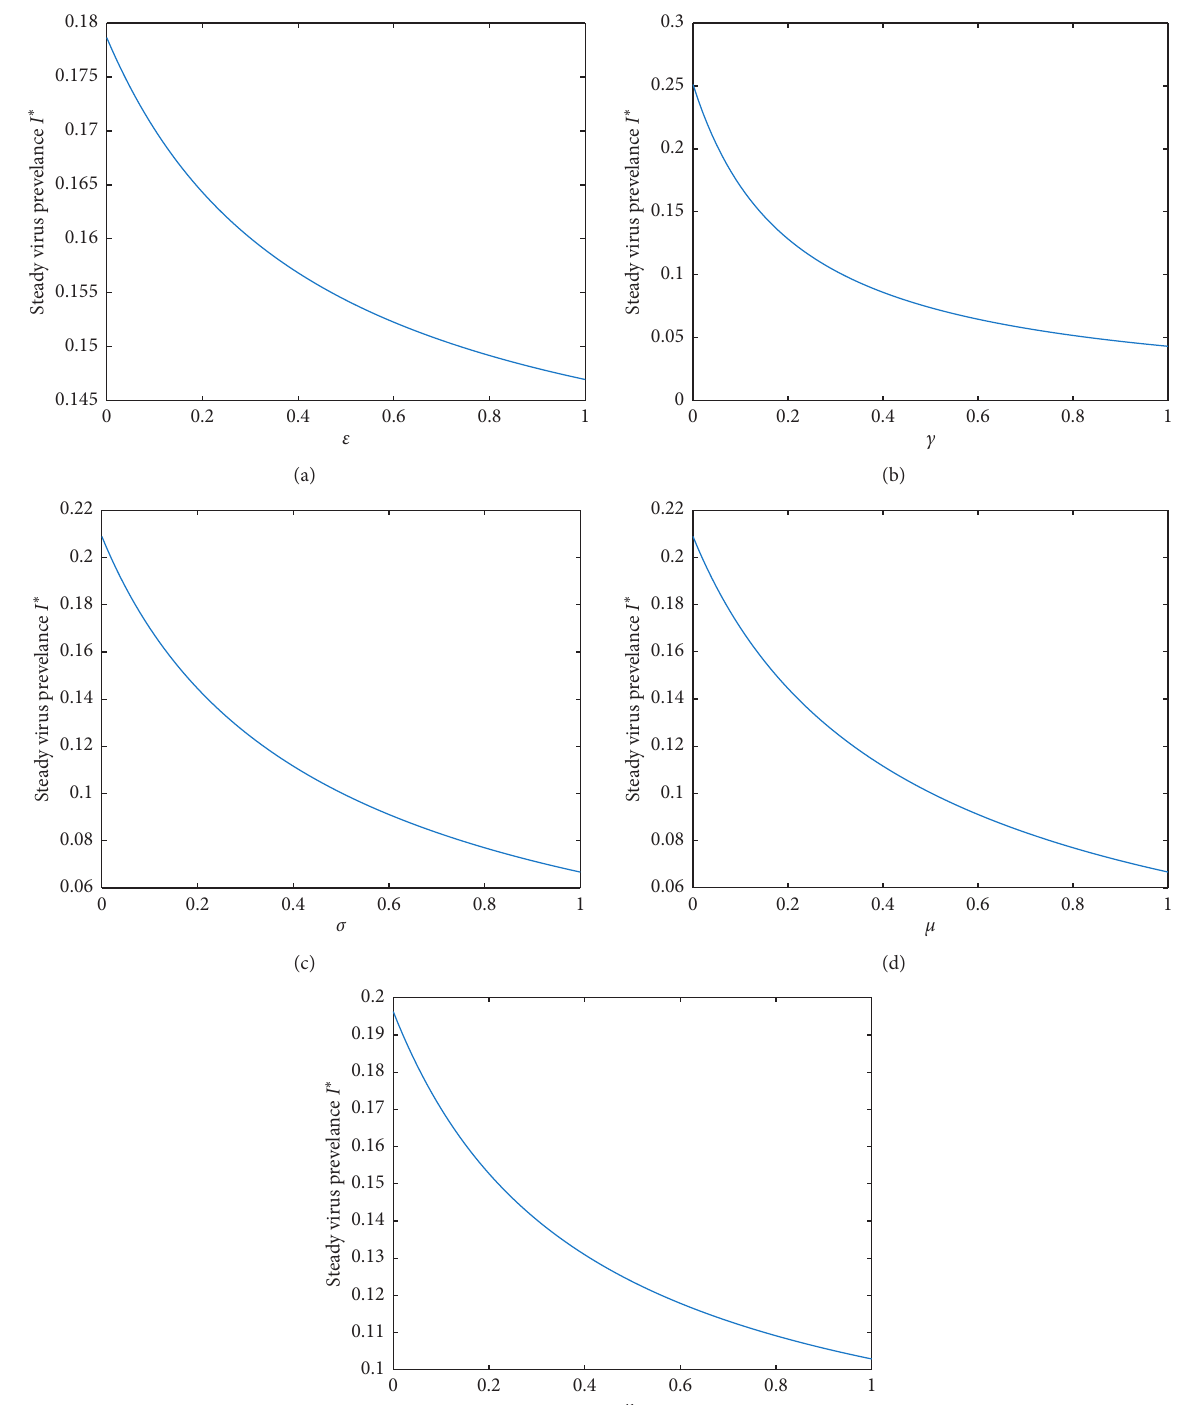
Figure 5: Alteration of I ∗ with the parameters: (a) ε , (b) c , (c) σ , (d) μ , and (e) η